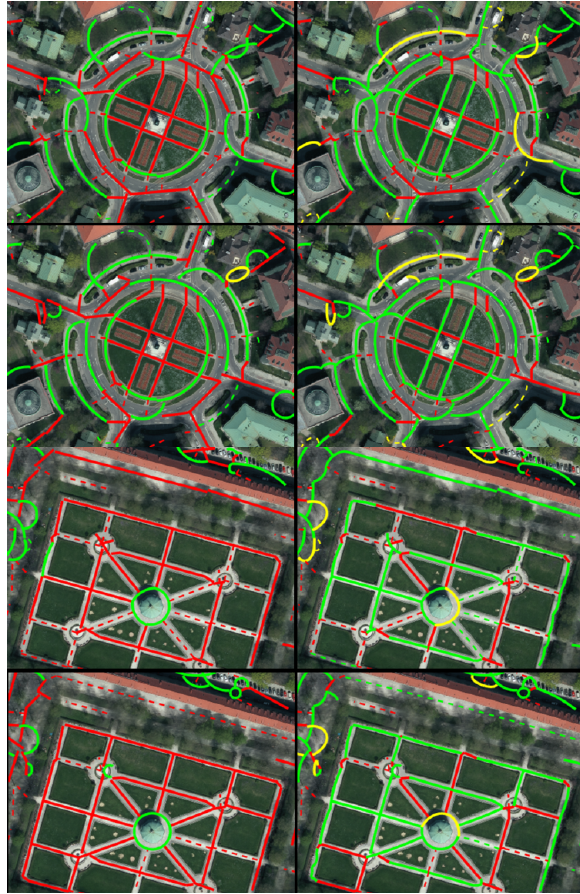
Figure 5: Detailed views of generalization results from two traffic roundabouts. The output of non-adapted and adapted generaliza- tion is shown, respectively, in the left and in the right images. The output of partial dominant directions and circle-fit + RANSAC is shown, respectively, in the top and in the bottom images. All el- ements stemming from a chain are highlighted with solid lines while the side roads are represented by dashed lines. We show the resulting circle and the ellipses arcs as well as the straight line segments by green, yellow, and red color, respectively.